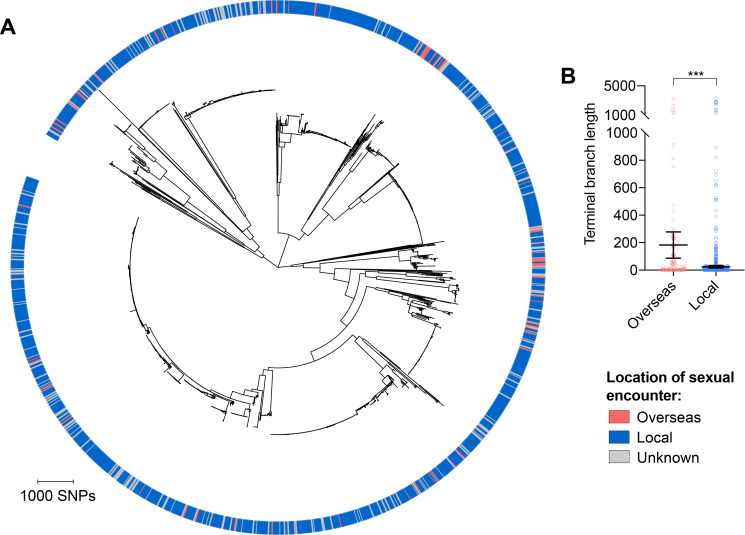
Isolates from patients with travel-associated gonorrhea are associated with longer terminal branches compared to patients with locally-acquired gonorrhea.Maximum-likelihood phylogeny produced from the pseudogenome alignment (with predicted regions of recombination removed) of isolates from dataset 2 (A). Patient travel history is indicated by the colored ring in A. Scatter dot plots showing the terminal branch lengths (with lines indicating the mean and 95% confidence intervals) associated with isolates from patients with travel-associated gonorrhea compared to patients with locally-acquired gonorrhea with asterisks indicating a significant difference (p<0.001 by Mann-Whitney U test) in terminal branch lengths between the two groups (B).